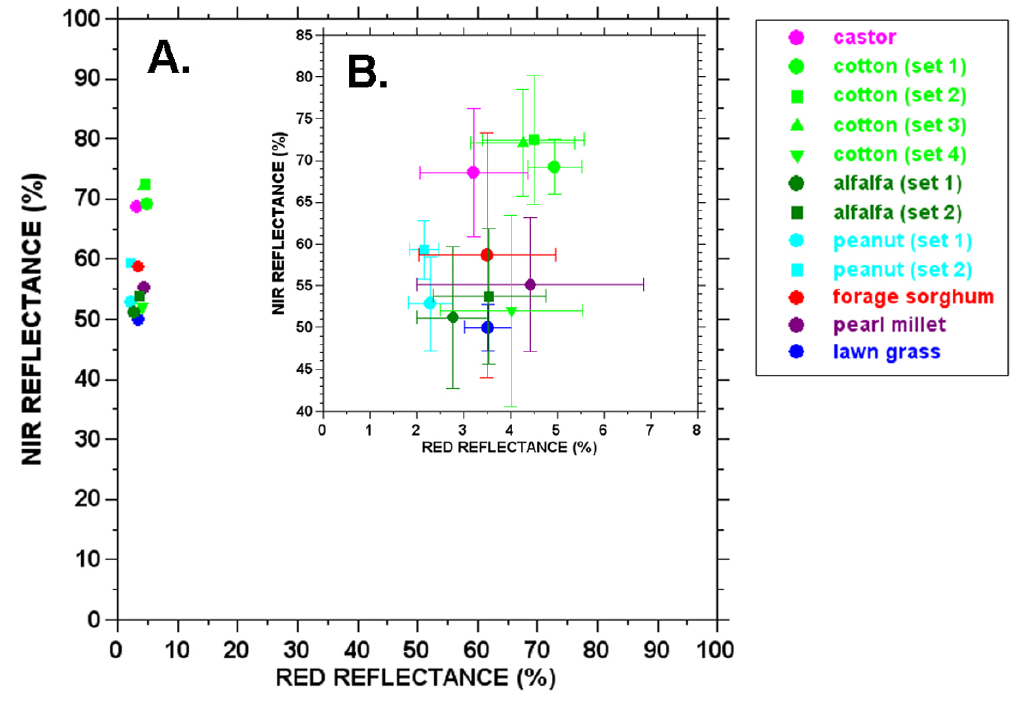
Figure 8. NIR versus red leaf canopy reflectance for the seven plant species used in this study. (A) Average values for each data set. (B) Detailed view of the cluster of values. Error bars represent plus or minus one standard deviation about the mean.